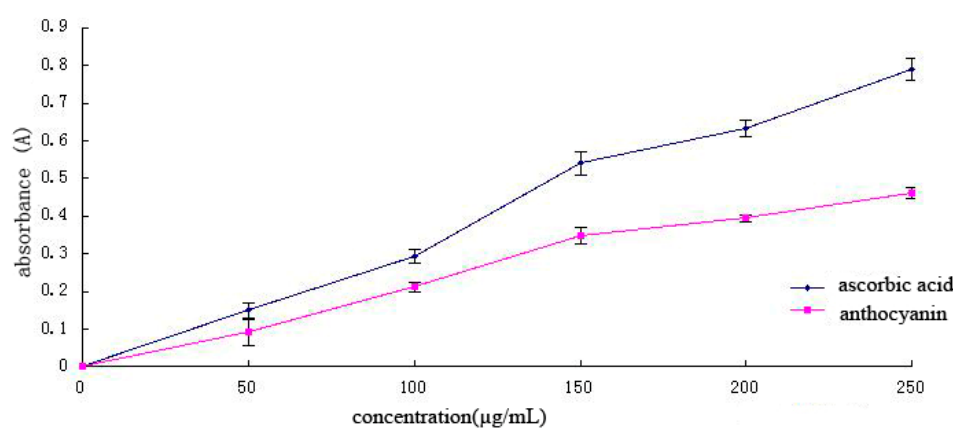
Figure 7. Total antioxidant capacity of different concentrations of ascorbic acid and Cy-3-glu solutions ( n = 3).